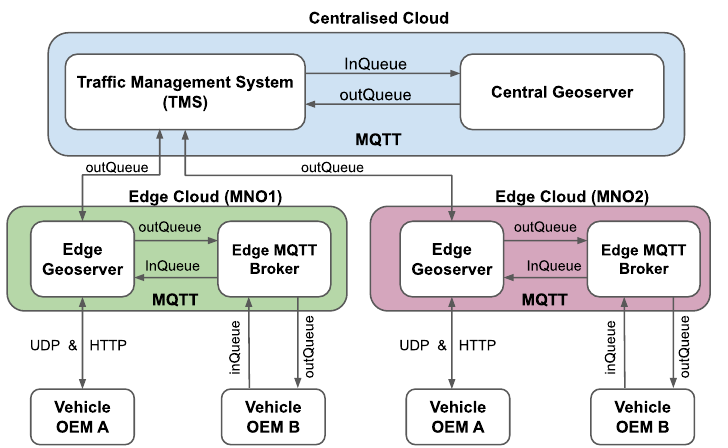
Figure 1. Anticipated cooperative collision avoidance (ACCA) service architecture with two connected vehicle original equipment manufacturers (OEMs). Vehicle OEM A communicates over the UDP/IP and HTTP protocols, and vehicle OEM B communicates over the TCP/IP with MQTT